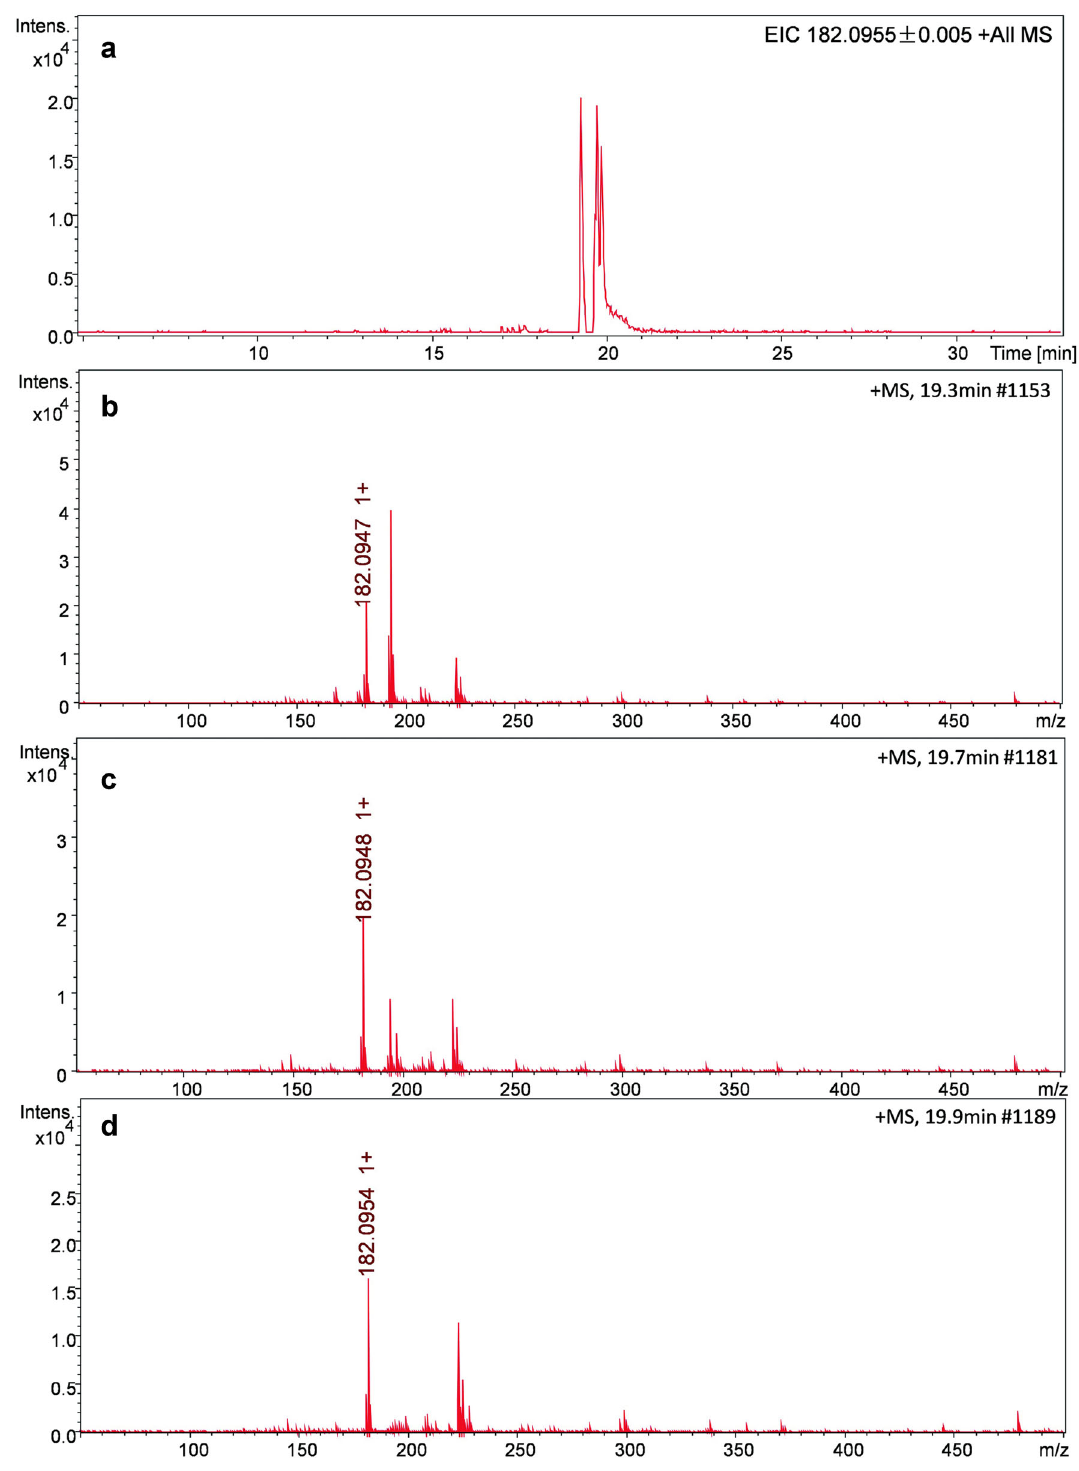
Fig. 6 EIC ( a ) and mass spectra ( b and c ) of isomers of [C 13 H 12 N] ? ( m / z = 182.0955) detected by